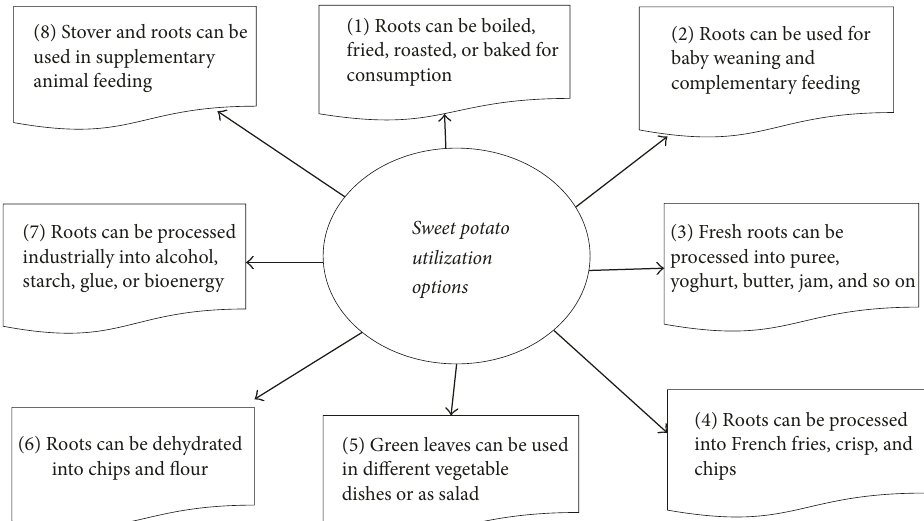
Figure 1: Options for utilizing various parts of sweet potato.